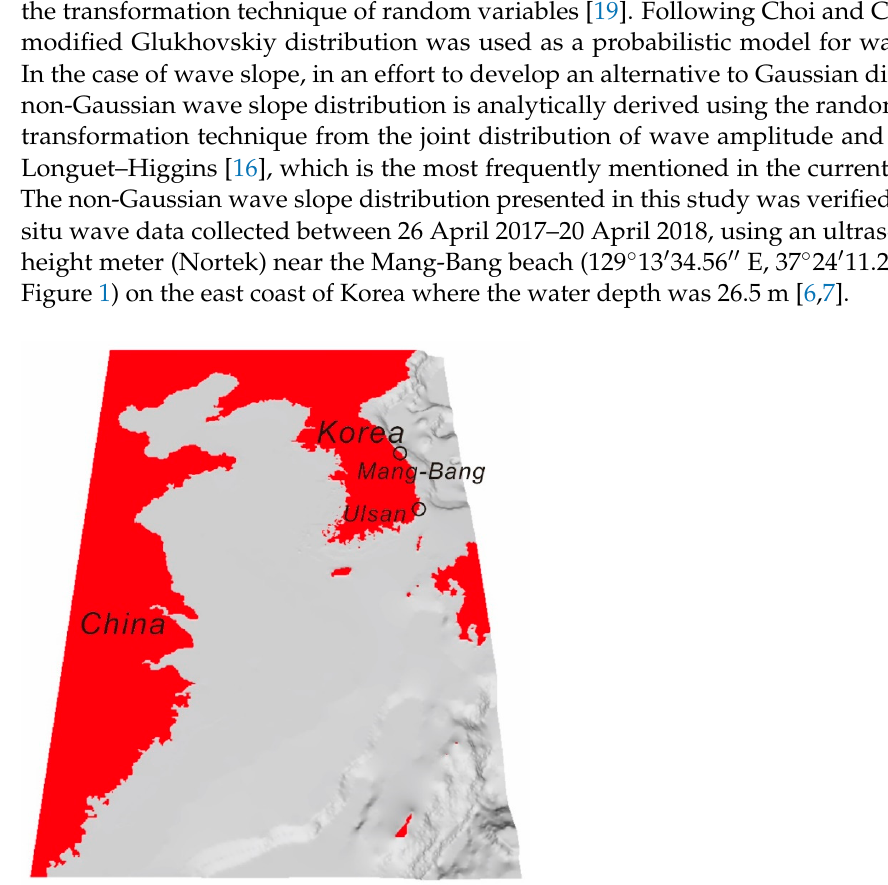
Figure 1. Map of the study area.